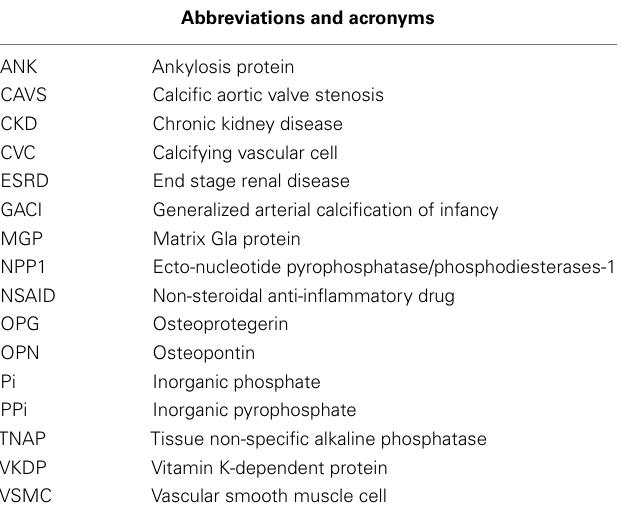
Table 1 |Abbreviations and